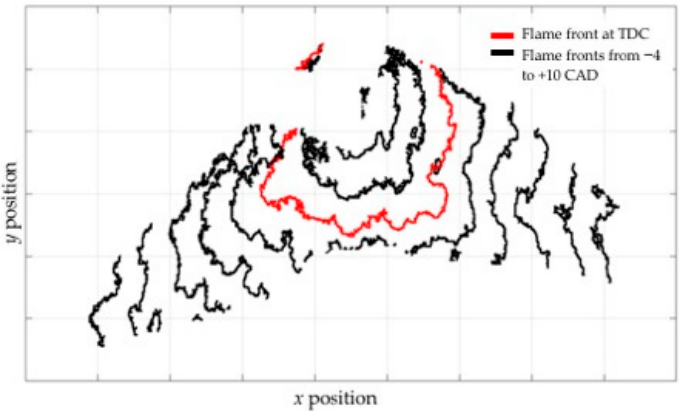
Figure 10. Flame edges detected for 1000 RPM @ 730mmHg ( − 4 to + 10 CAD with respect to TDC). CAD: crank angle degrees; TDC: top dead center.